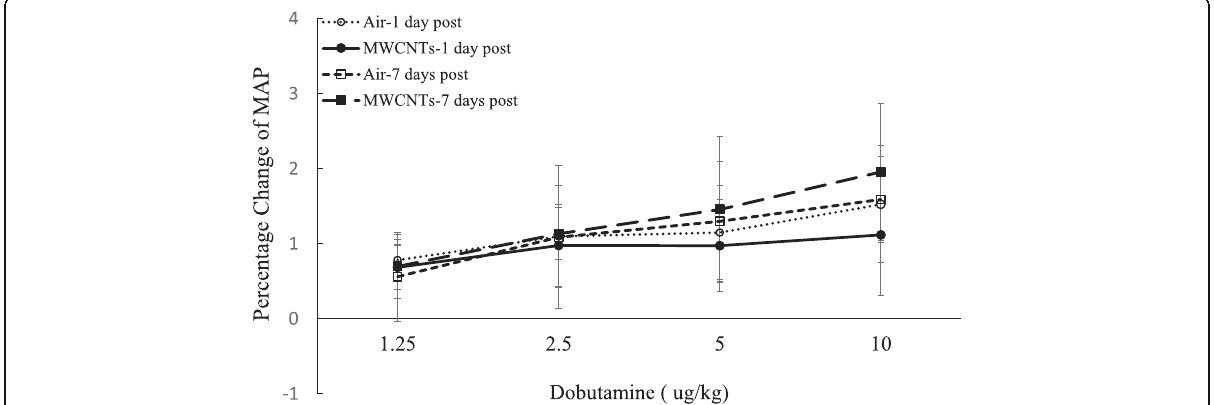
Fig. 6 Line graph depicting a percentage change of mean blood pressure (MBP) from the basal level before exposure (control vs MWCNTs at 1 day post: 97.7 ± 2.8 vs 98.1 ± 2.6, control vs MWCNTs at 7 days post: 102.5 ± 4.2 vs 100.9 ± 5.5). Each value represents the mean ± SE of eight